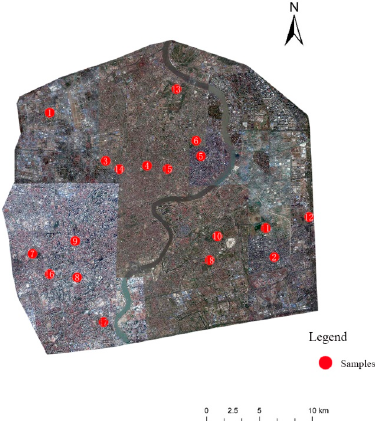
Figure 3. Location of the 18 water bodies in Shanghai (marked in red